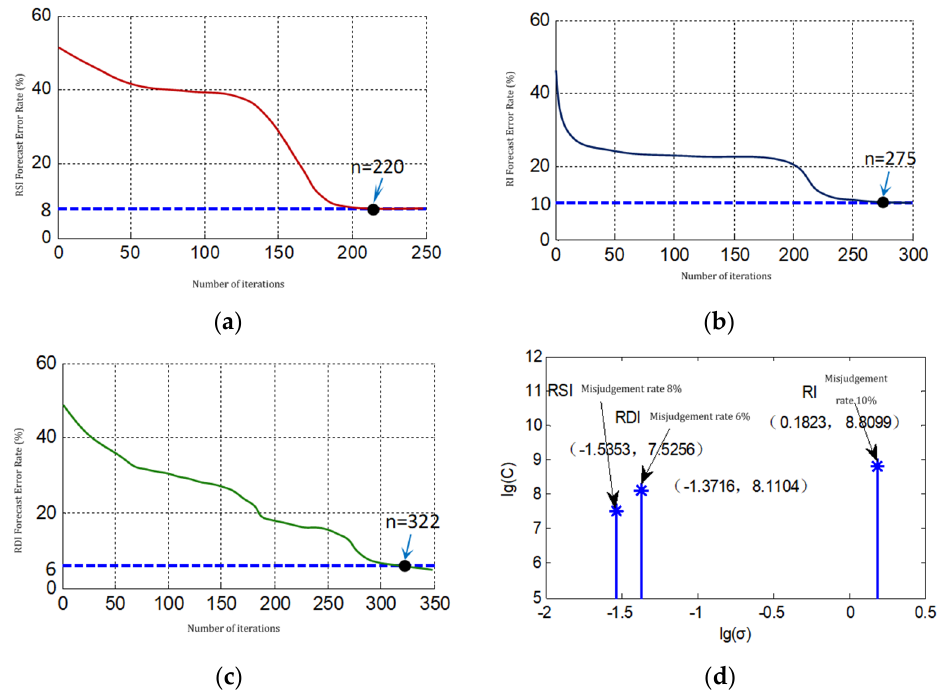
Figure 5. Prediction of pellet metallurgical properties based on algorithm 6. ( a ) The relationship between the number of iterations and the error rate of RSI forecast. ( b ) The relationship between the number of iterations and the error rate of RI forecast. ( c ) The relationship between the number of iterations and the error rate of RDI forecast. ( d ) The best kernel parameter and its corresponding forecast misjudgment rate.